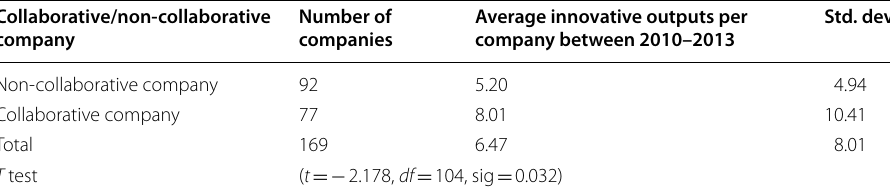
Table 1 Cross tabulation of total productivity by collaboration Collaborative/non-collaborative